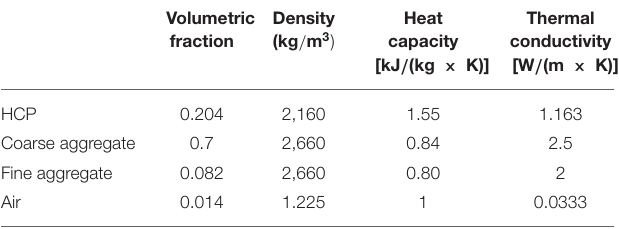
TABLE 1 | Properties of each component in beam model.